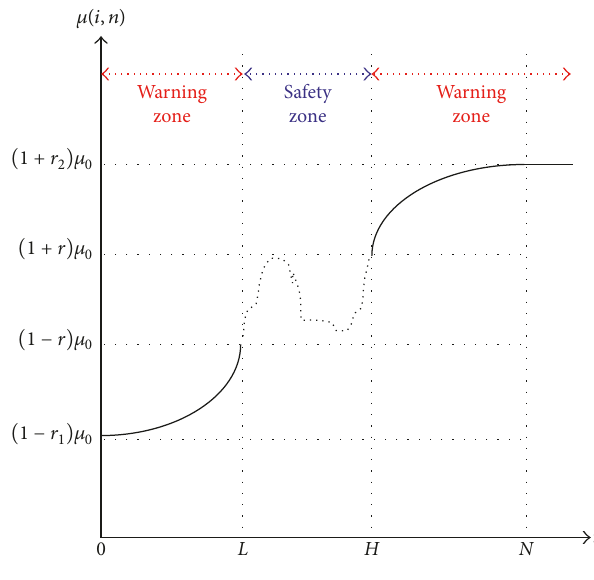
Figure 1: Playout rate function of the proposed AMP [22].